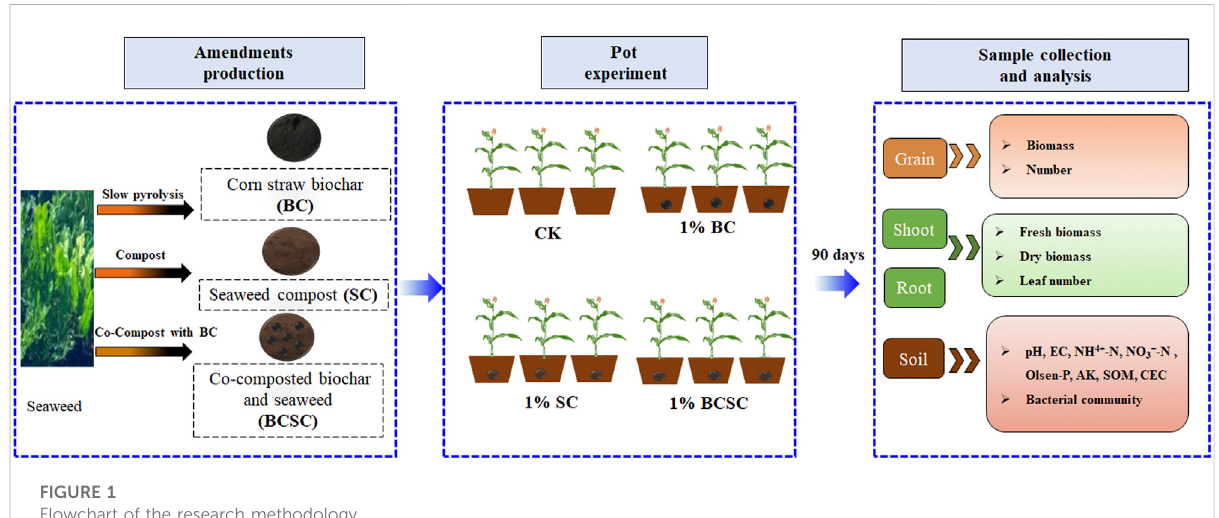
FIGURE 1 Flowchart of the research